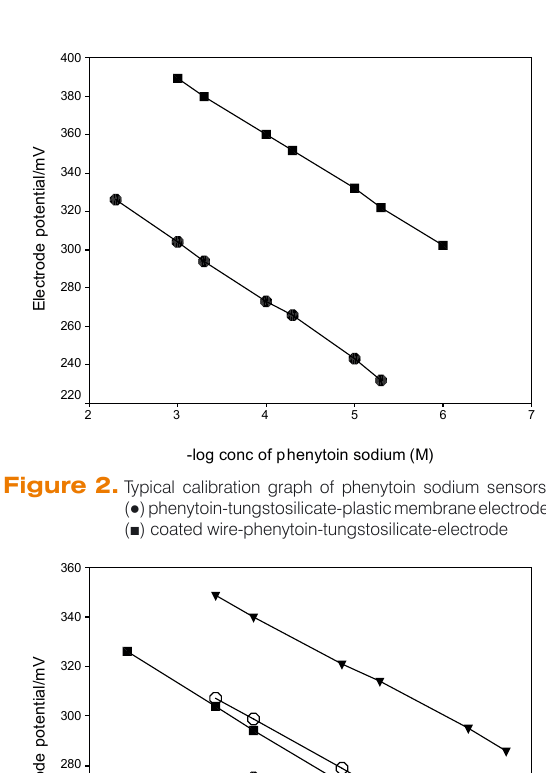
Figure 3. Optimization of plasticizers. DBS( ● ) (PVC membrane composition: DBS 60.0 wt%, PVC 39.0 wt%, ion-pair, 1.0 wt%), o-NPOE ( ■ ) (PVC membrane composition: o-NPOE 66.0 wt%, PVC 31.5 wt%, ion pair, 2.5 wt%), DBP ( ○ ) (PVC membrane Composition: ( DBP 64.0 wt %, PVC 35.0wt%, ion-pair, 1.0 wt%), ( ▼ ) DOP (PVC membrane composition: (DOP 70.0 wt%, PVC 28.0 wt%, ion-pair, 2.0 wt %